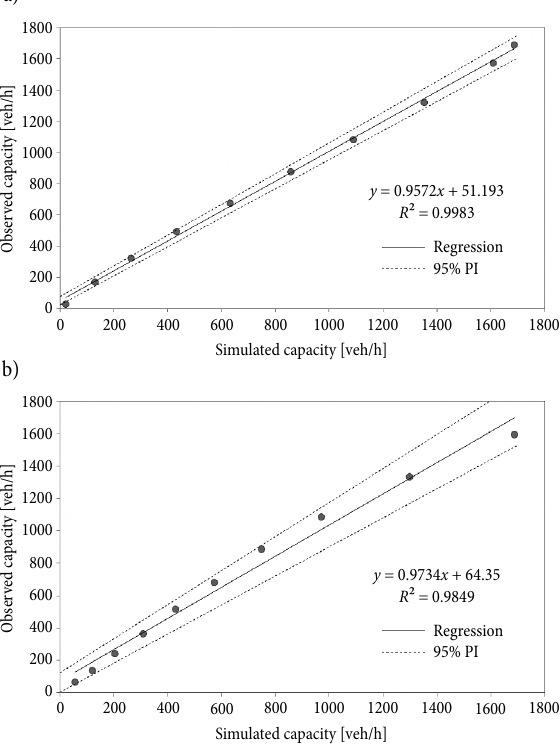
Fig. 3. Observed versus simulated capacities at major entries: a – the right-lane; b – the left-lane